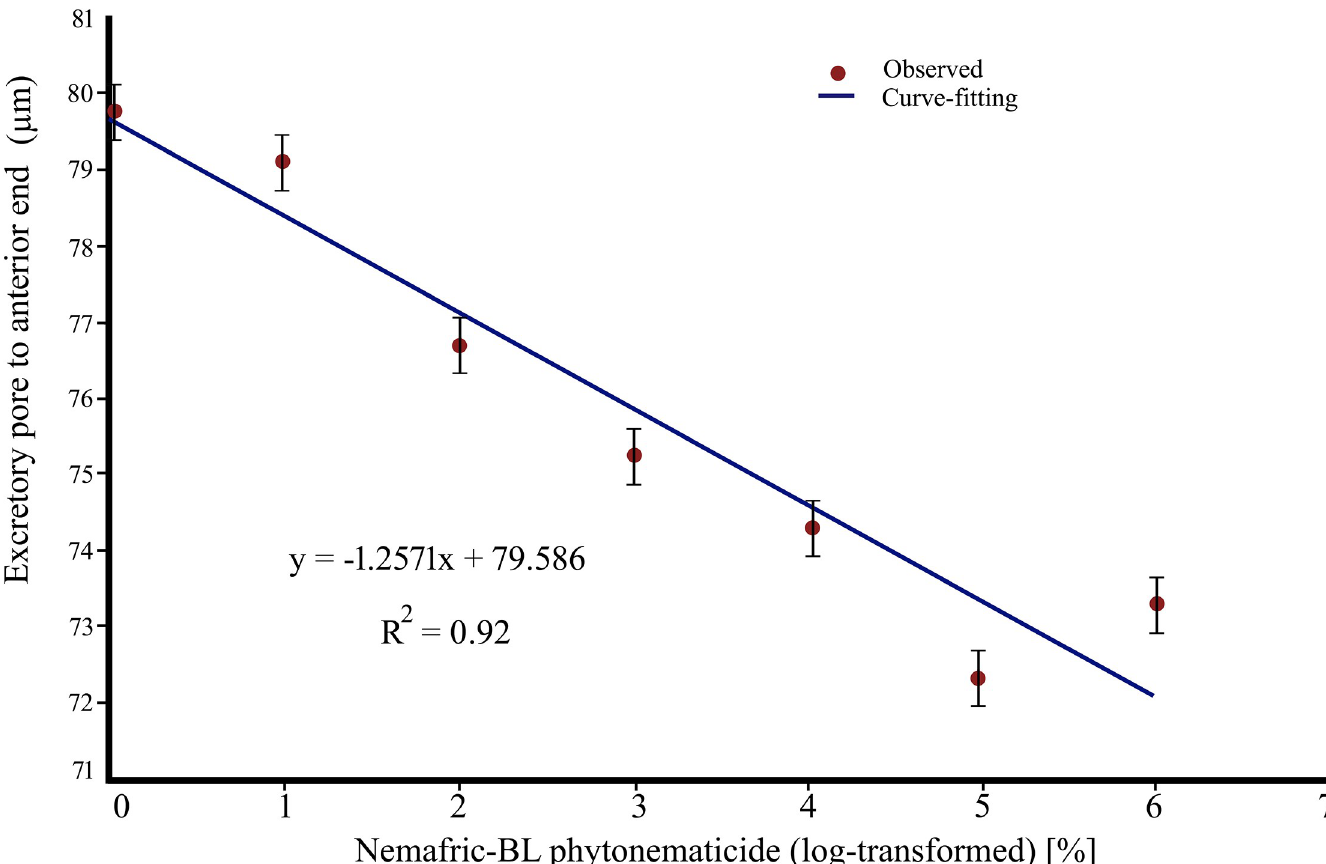
Fig 5. Negative linear relation in Steinernema feltiae excretory pore to anterior end length versus Nemafric-BL phytonematicide.